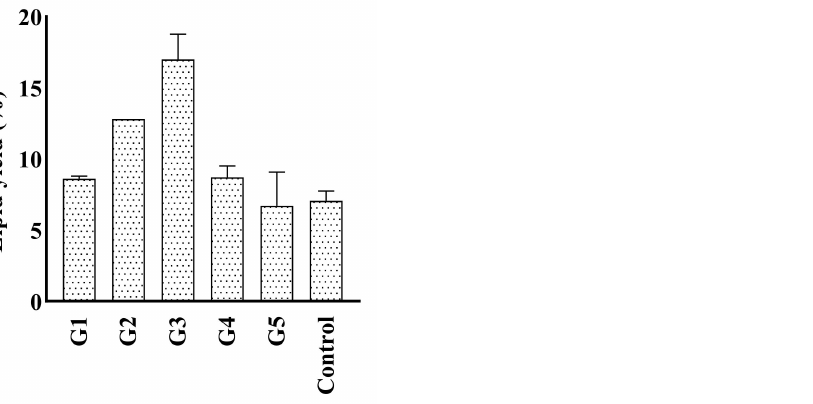
Figure 4. Lipid yields from BSFL fed with different ratios of blended sewage